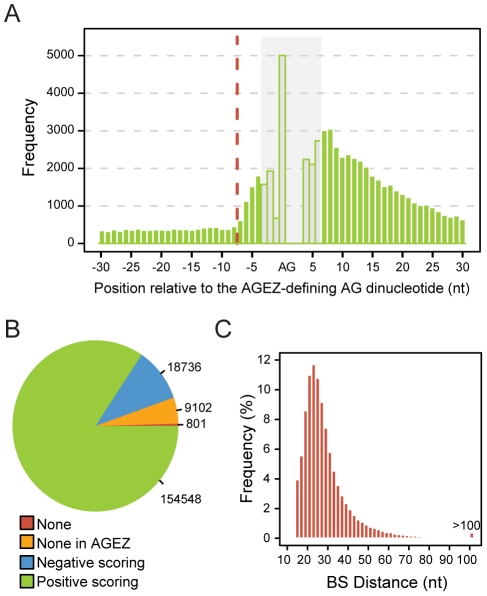
Predicted human branch points.
A – Histogram representing the distribution of BS positions relative to the AGEZ-defining AG-dinucleotide (a3 in Figure 1). Grey region represents positions that are biased by the presence of the AG dinucleotide. The dashed red line represents the leftmost point where the distribution is different from an expected uniform distribution. The AG dinucleotide exact position is shown on the x-axis. For this plot, top scoring candidates over the last 500nt were considered in order to obtain the left background tail. For visualization purposes only positions from −30 to +30 nts relative to the AG are shown. B – Pie chart showing the number of introns in the initial dataset (N = 183187) for which no predictions were obtained (None), no predictions falling inside the 1st AGEZ were obtained (None in AGEZ), the top prediction inside 1st AGEZ has a negative SVM score (Negative scoring) and the top prediction inside the 1st AGEZ scores positively (Positive scoring). C – Histogram showing the distribution of predicted BS distances relative to the 3SS. Only top scoring candidates inside the AGEZ were considered.